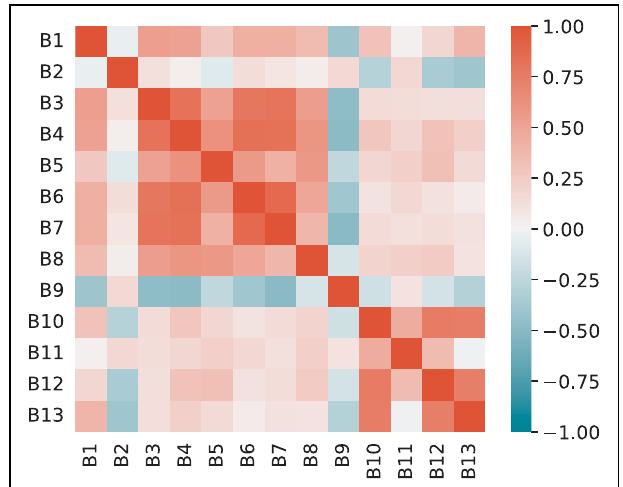
FIGURE 4 | Pearson correlation of building